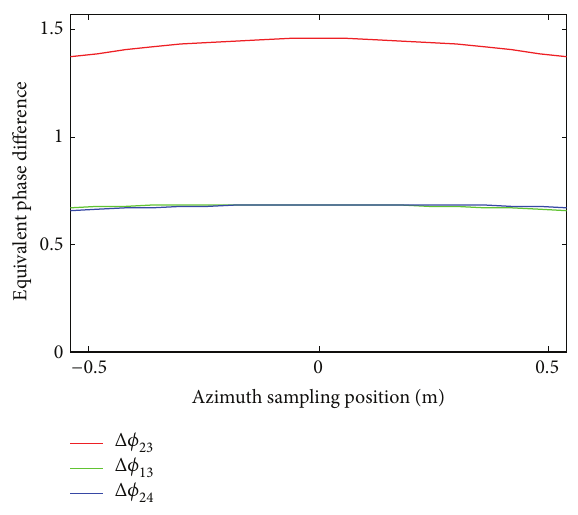
Figure 8: Equivalent phase difference as a function of azimuth sampling position.